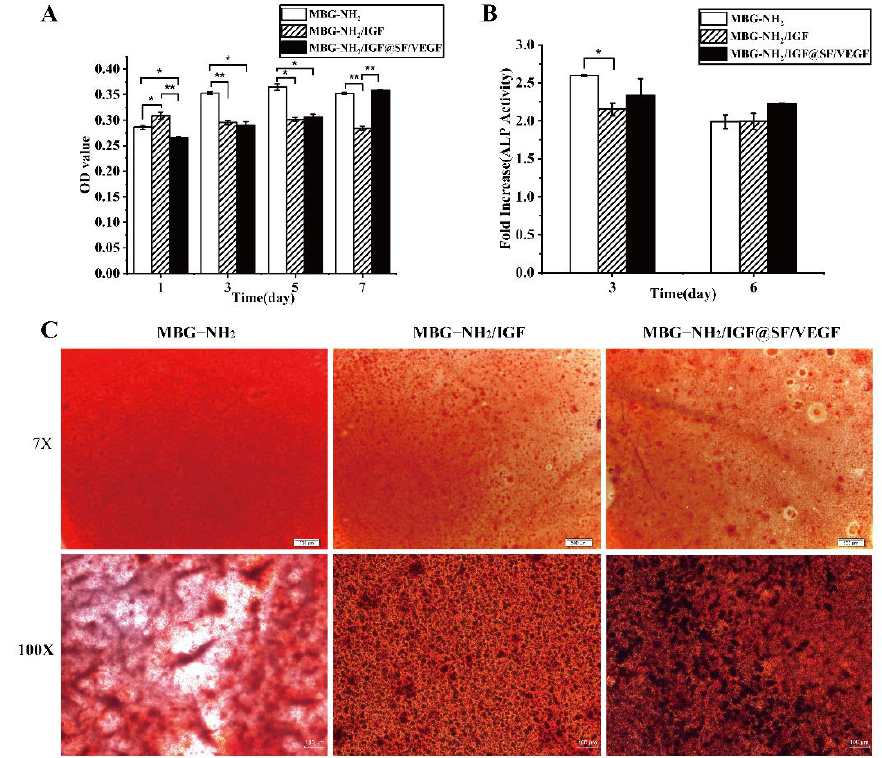
Figure 2. Proliferation, differentiation and mineralization of BMSCs cultured on MBG-NH 2 , MBG-NH 2 /IGF and MBG-NH 2 /IGF@SF/VEGF scaffolds. ( A ) Proliferation of BMSCs cultured on the scaffolds for 1, 3, 5 and 7 days. ( B ) ALP activity of BMSCs cultured on the scaffolds for 3 and 6 days. ( C ) Mineralization deposits stained with alizarin red of BMSCs cultured on the scaffolds for 14 days. Scale bars of 7 × magnification: 500 µ m; scale bars of 100 × magnification: 100 µ m. Experimental data were analyzed as indicated and reported as mean ± SE. (* p < 0.05; ** p < 0.01).